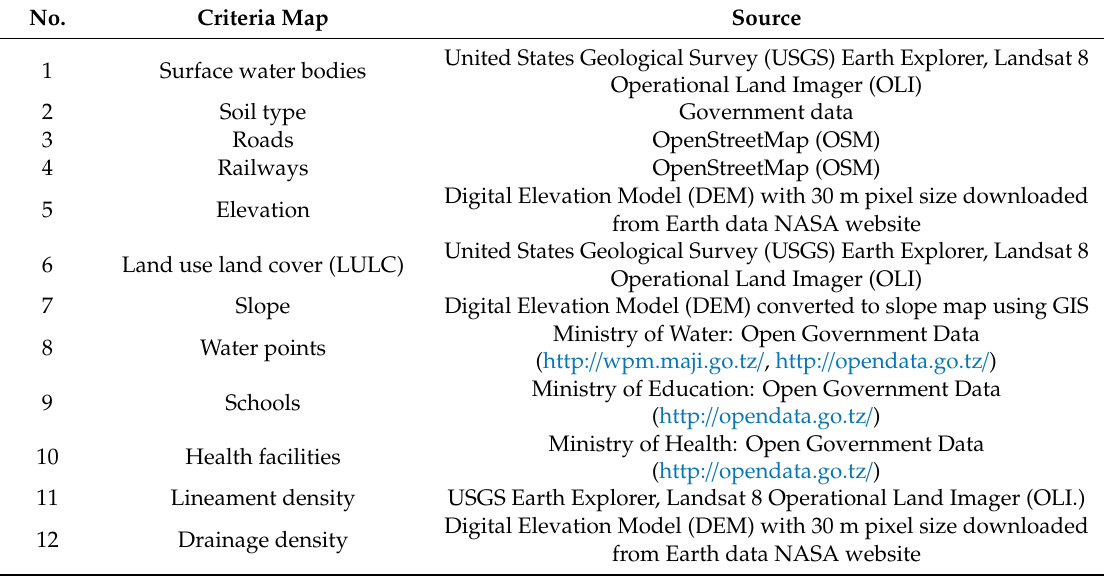
Table 1. Source of